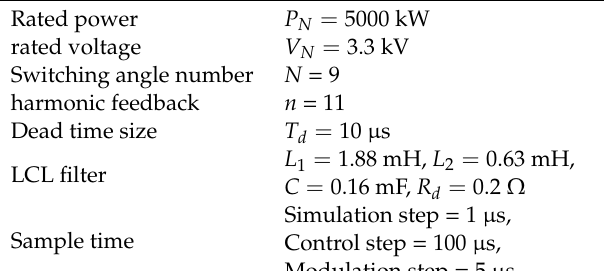
Table 2. Simulation parameters.